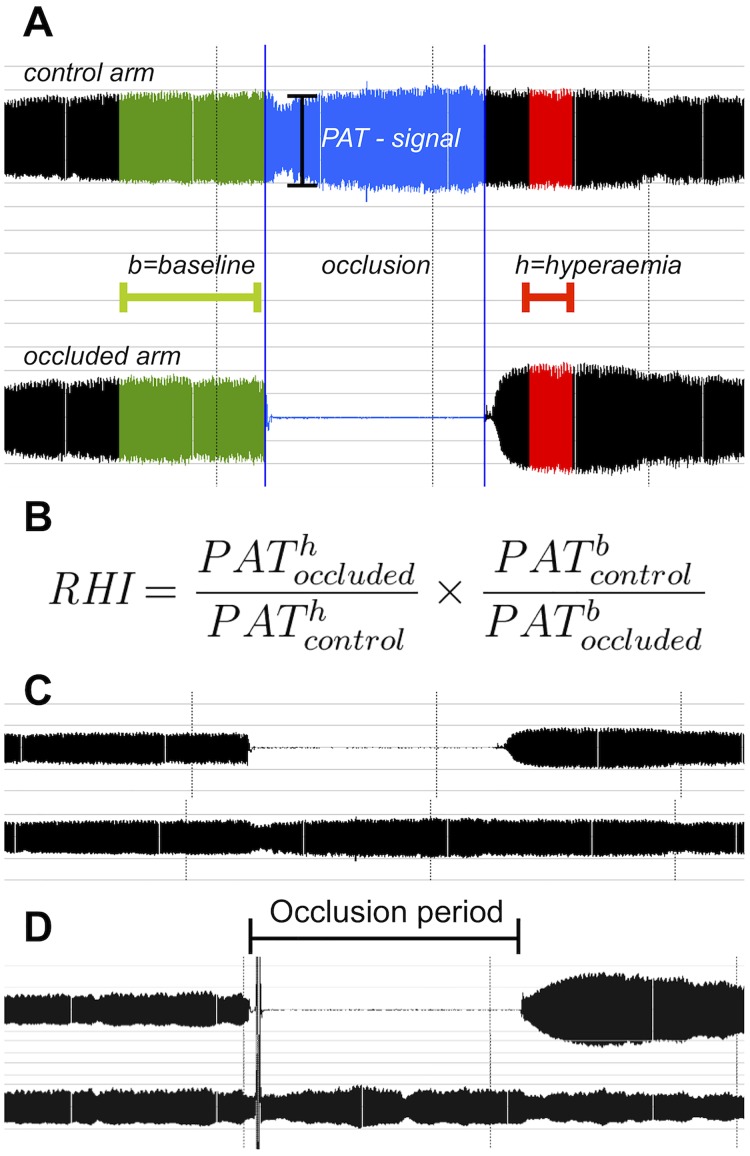
Illustration of reactive hyperaemia peripheral arterial tonometry (PAT).Depicted are a measurement (A) with colour-coded intervals corresponding to parameters required for the reactive hyperaemia index equation (B). Tracings derive from beat-to-beat finger volume changes captured by plethysmographic finger cuffs on the index fingers of both hands. The interval 60–120 seconds post cuff release is best linked to coronary microvasculature dysfunction as published by Bonnetti et al. [17]. Additionally the comparison of a pathologic (C) and a normal (D) hyperaemia responses as recorded by fingertip plethysmography is shown. RHI, reactive hyperaemia index.